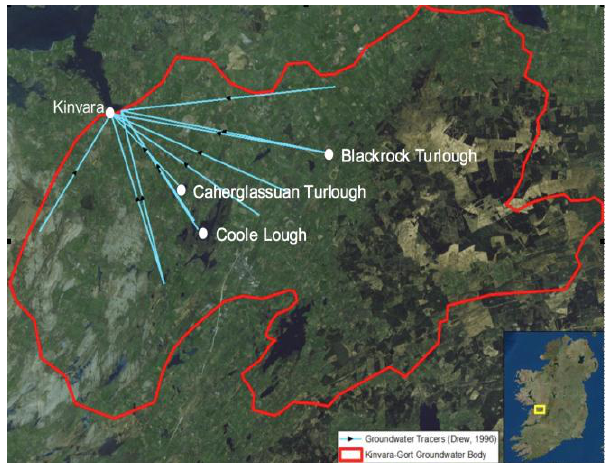
Figure 2. Hydrological connections to Kinvara Bay identified using groundwater tracers [11]. The blue lines represent subterranean pathways due to the Karst nature of the region that result in a number of inter-tidal discharges of cooler freshwater into the inner bay.